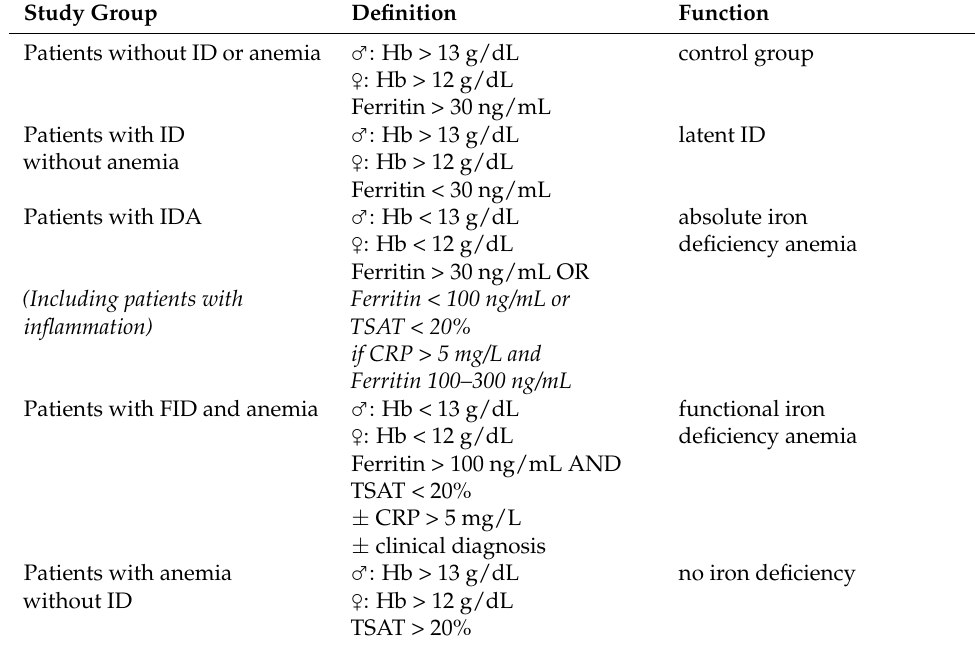
Table 1. Criteria for patient allocation to study